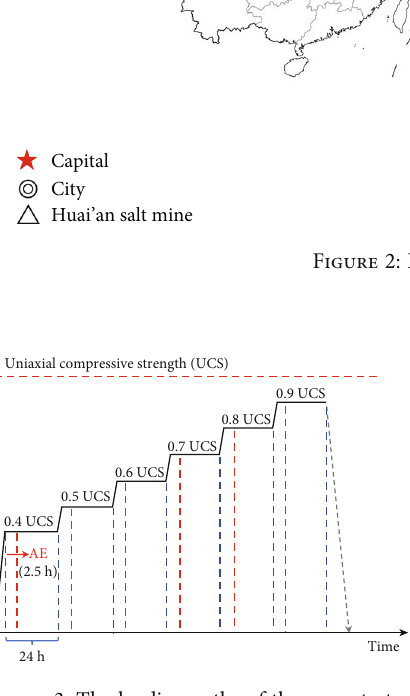
Figure 3: The loading paths of the creep test.